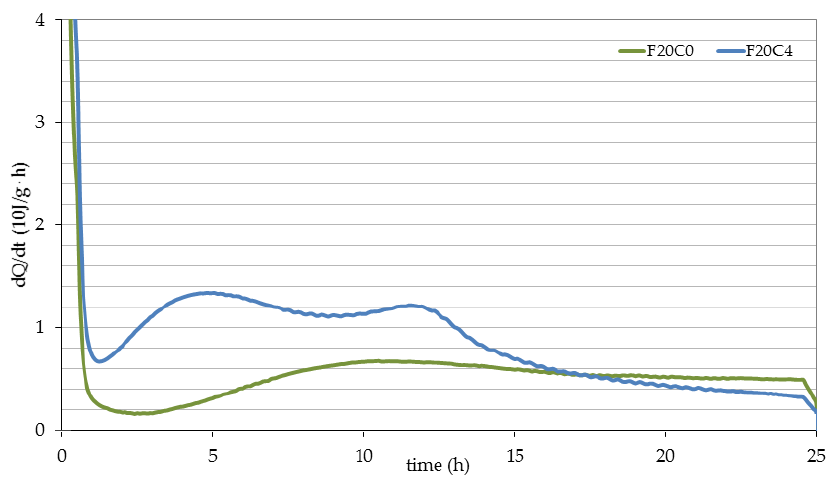
Figure 7. The amount of heat released during the curing of cement pastes.